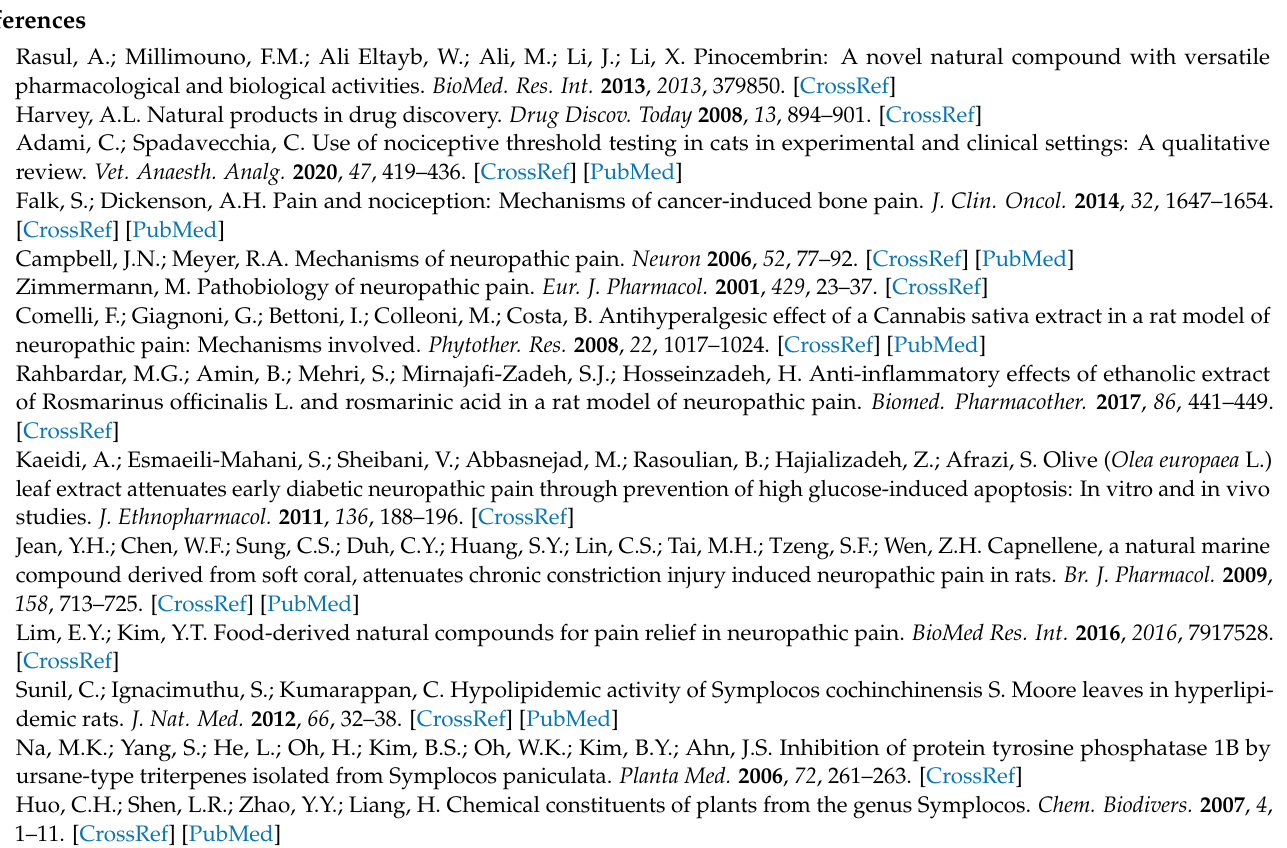
Figure S4: HMBC of 5-HMF, Figure S5: EI-MS of